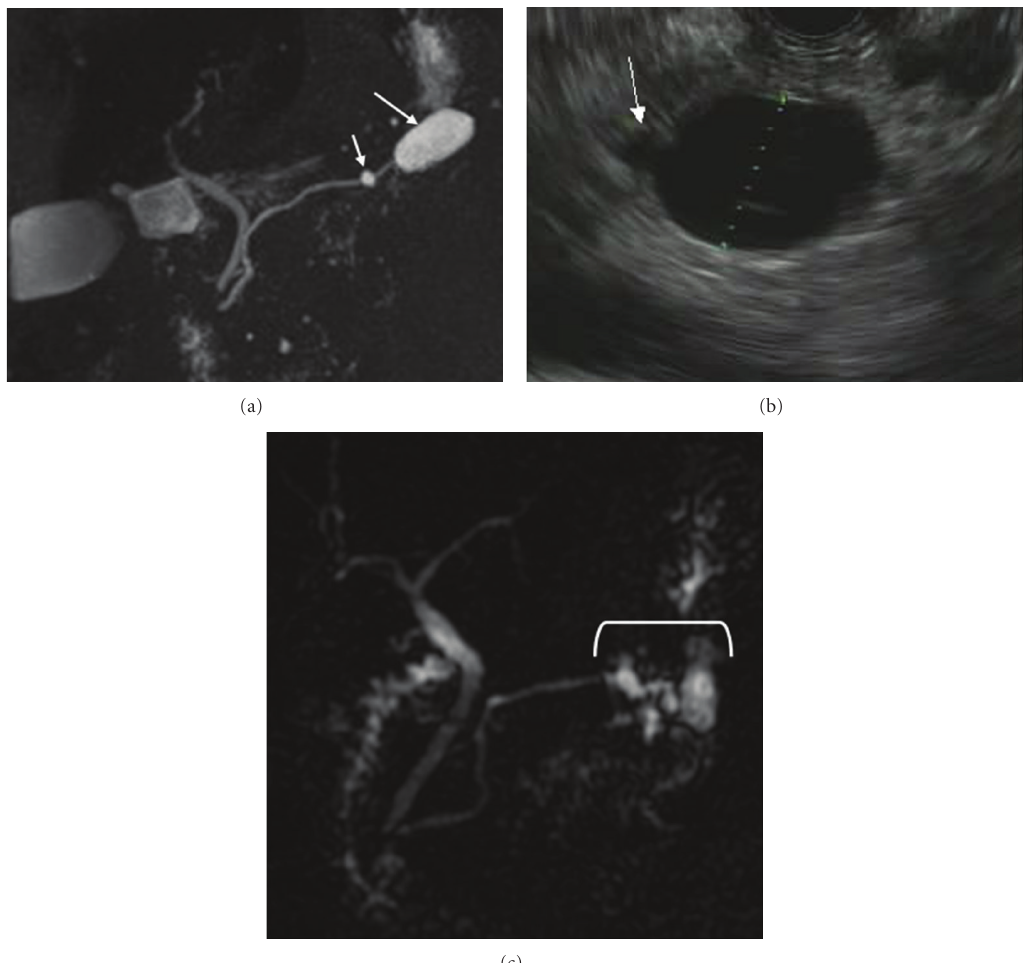
Figure 1: Imaging of BD-IPMN and mixed IPMN. (a) MRI of BD-IPMN: arrow points to communication between BD-IPMN and normal main pancreatic duct. (b) EUS of BD-IPMN: arrow points to communication between cyst and main pancreatic duct. (c) MRI of mixed IPMN: arrow points to di ff usely massively dilated main pancreatic